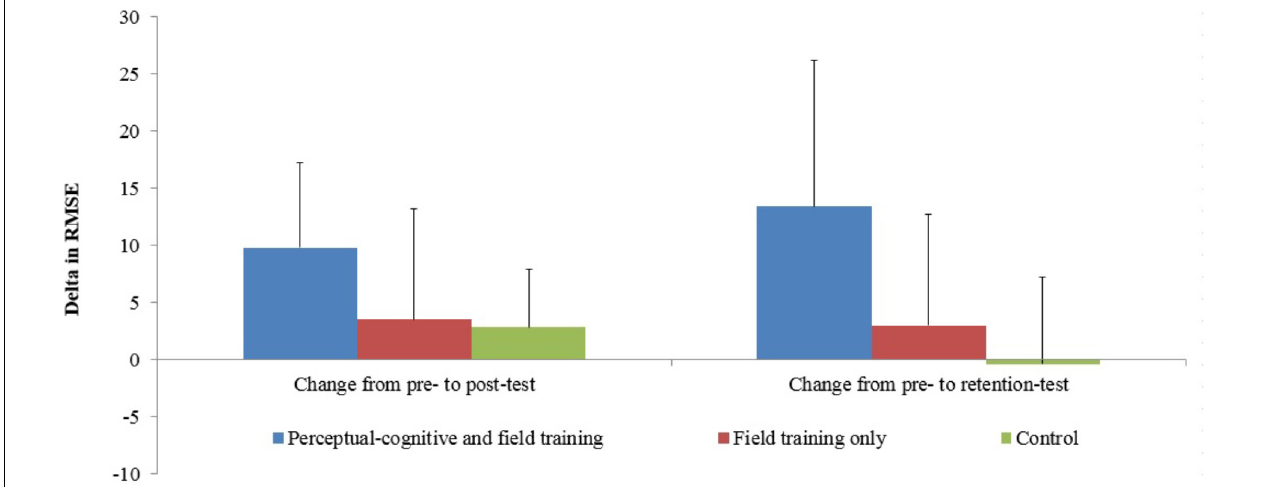
FIGURE 2 | Comparison of changes from pre- to post-test (left bars) and from pre- to retention-test (right bars; bars indicate means while the lines above reflect standard deviations).